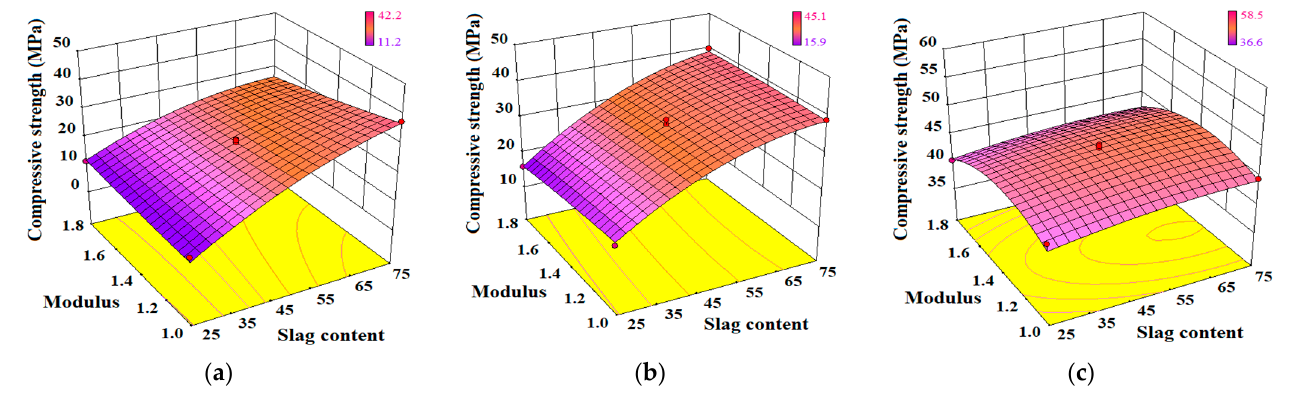
Figure 12. Effect of interaction between W SG and M on the compressive strength model of AA-FASM. ( a ) 1 day. ( b ) 3 days. ( c ) 28 days.